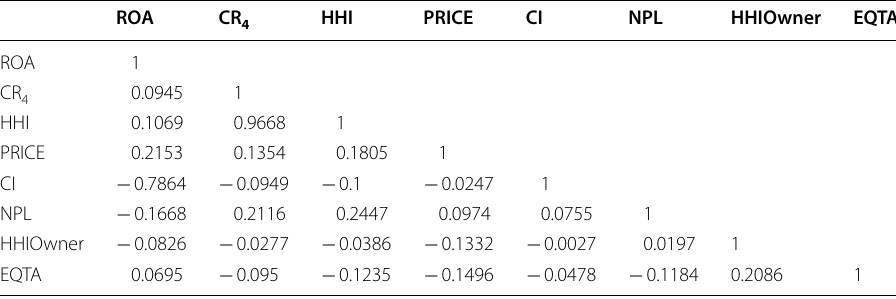
Table 2 Correlation matrix. Source: Author’s calculation on data provided by the Indonesia Financial Services Authority